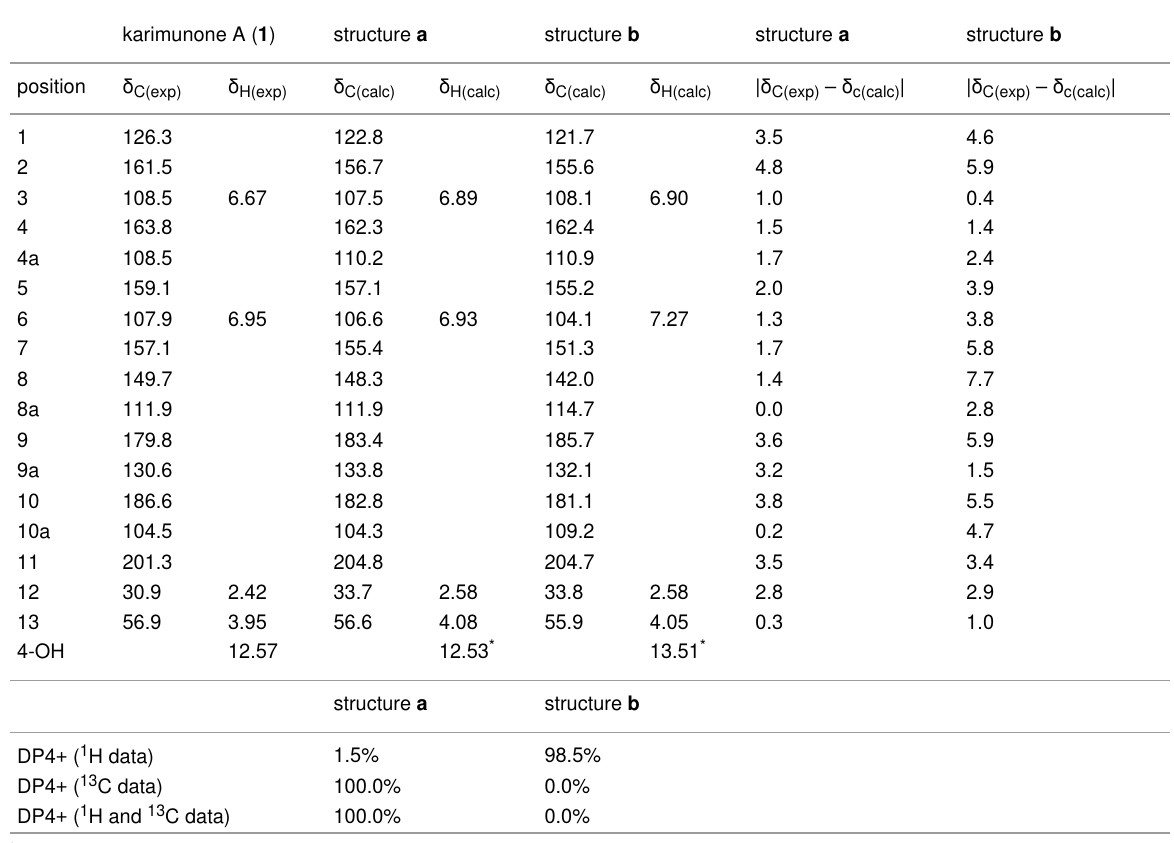
Table 2: DFT-calculated NMR chemical shifts of two possible structures a and b for karimunone A ( 1 ) at the mPW1PW91/6-31G+(d,p)-PCM(DMSO)